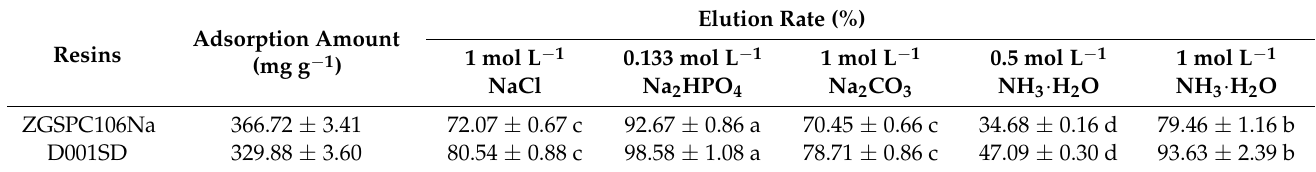
Table 5. Elution efficiency of L-theanine by different